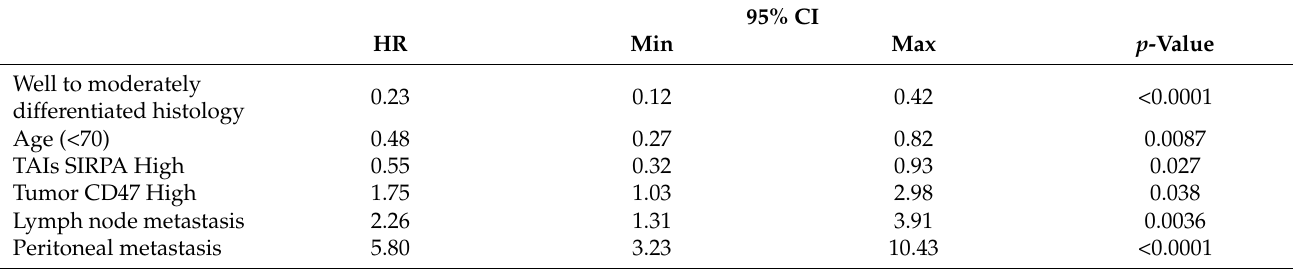
Figure 4. Overall survival of patients with colorectal cancer classified according to CD47, SIRPA, CD68, and CD163 expression. Kaplan–Meier curves for patients classified by CD47 ( a ), SIRPA ( b ), CD68 ( c ), and CD163 ( d ) expression. ( a ) Patients with CD47-positive CRC had significantly worse overall survival ( p = 0.0268). ( b – d ) Overall survival was not correlated with the presence of SIRPA- ( b ), CD68- ( c ), or CD163-positive TAIs. Table 3. Multivariable Cox hazards analysis of colorectal cancer patients. The multivariable Cox hazards analysis model initially included sex, age, tumor size, primary tumor location, pT stage, tumor histology, mucus production, lymph node metastasis, peritoneal metastasis, distant organ metastasis, operation status, mismatch-repair system status, and immunohistochemistry for CD47, SIRPA, CD68, and CD163. A backward elimination with a threshold of p = 0.05 was used to select variables in the final model. TAIs, tumor-associated inflammatory cells.